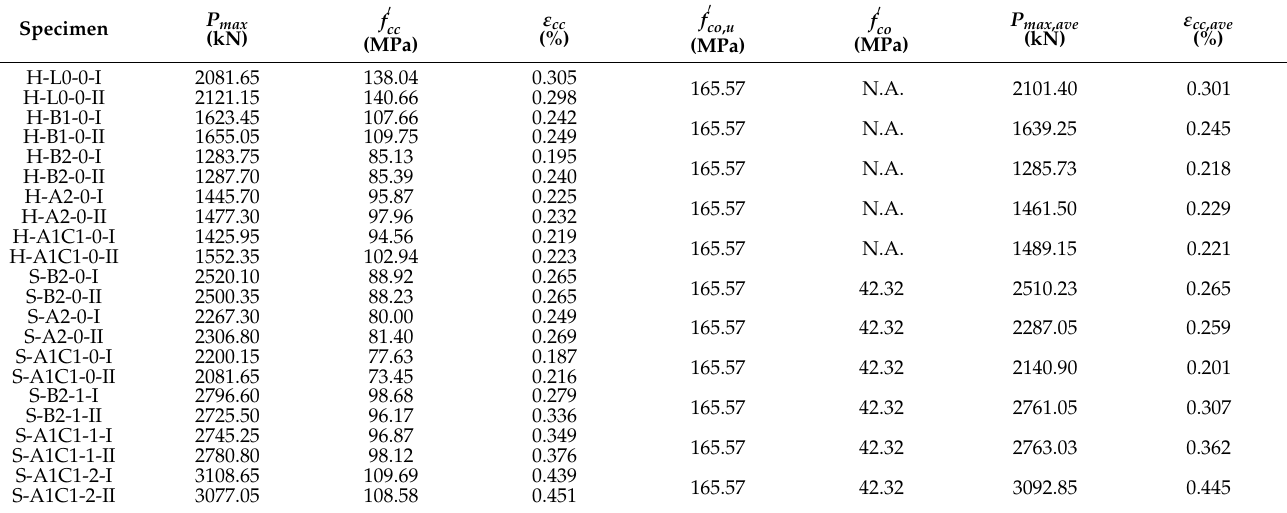
Table 3. Summary of key test results.